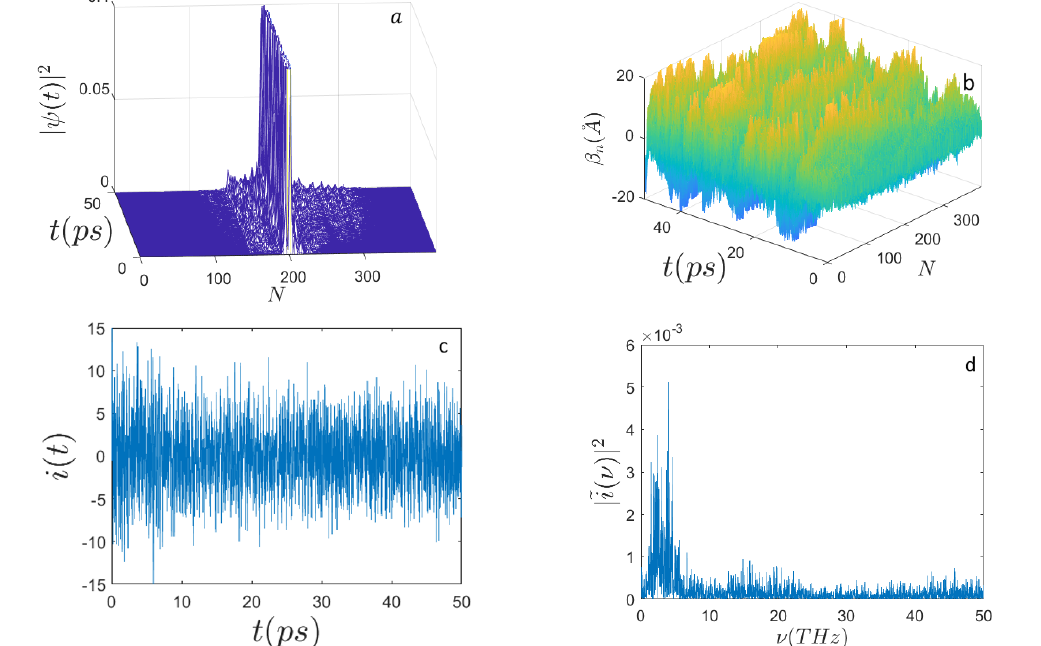
Figure 1. Time evolution of ( a ) the electron probability amplitude | Ψ ( t ) | 2 ; ( b ) the average displace- ments β n ( ˚ A ) ; ( c ) the electron current i ( t ) (expressed in µ biot); ( d ) the frequency spectrum | ˜ i ( ν ) | 2 along the sequence of N = 398 nucleotides. Initial conditions: T = 310 ◦ K, n 0 = N /2, E (cid:48) = 100, (cid:101) (cid:48) = 5, Ω (cid:48) = 0.25, µ (cid:48) = 0.5, σ 0 = 0.1, and the site-dependent parameters J (cid:48) n , and χ (cid:48) n corresponding to E 0 = 0.658 eV, (cid:101) = 0.0329 eV, Ω n = V 2 M n / a 2 , J n , and χ n in Equations (22) and (23), respectively. Initial electron excitation peaked around the site n 0 = N